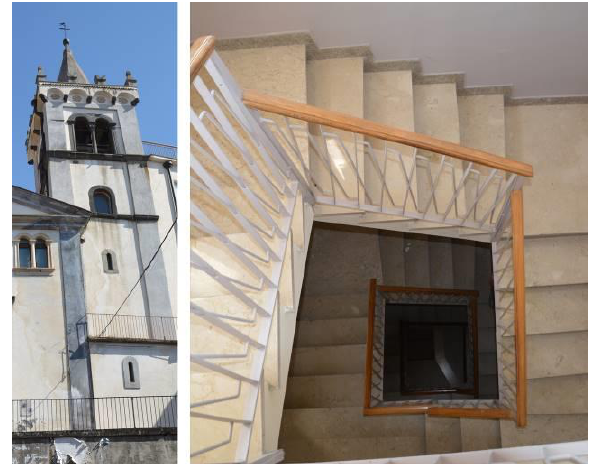
Figure 14. The bell tower of Santa Maria della Catena in Bronte (Ct). Inner